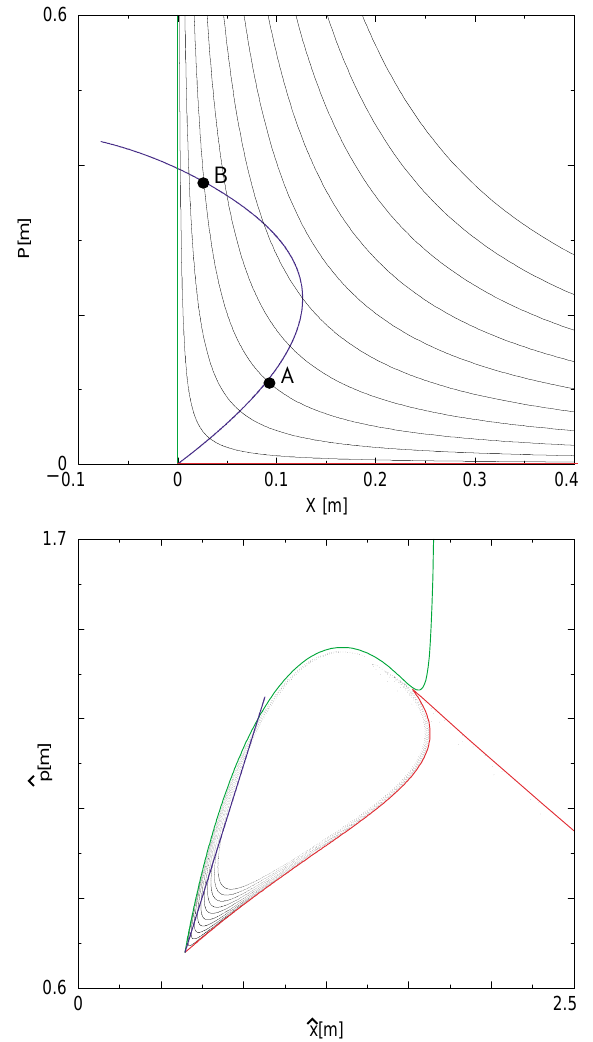
FIG. 3. (Color) (Bottom) Magnification of the top of Fig. 2 with the segment (blue) on which the initial conditions are chosen, the unstable (red) and stable (green) manifolds. (Top) Image in normal coordinates (cid:2) X , P (cid:3) of a neighborhood of the hyperbolic point, the initial conditions segment (blue curve), and the stable ( P axis) and unstable ( X axis) manifolds.